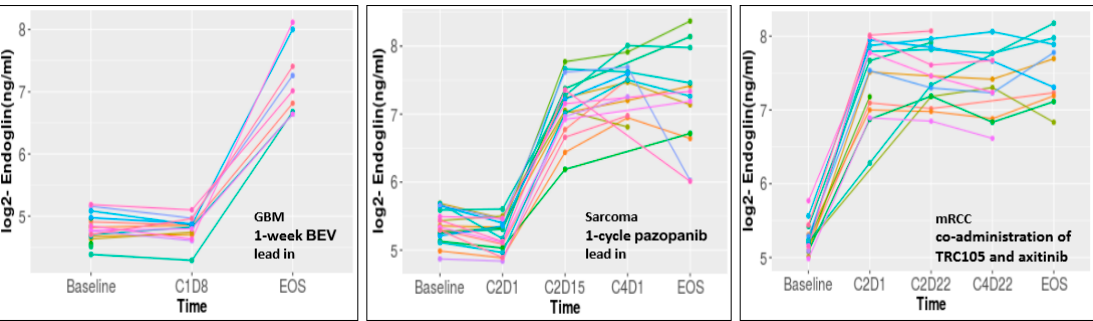
Figure 3. TRC105 increases sEng levels in circulation of patients. Each individual patient is represented by a colored line.